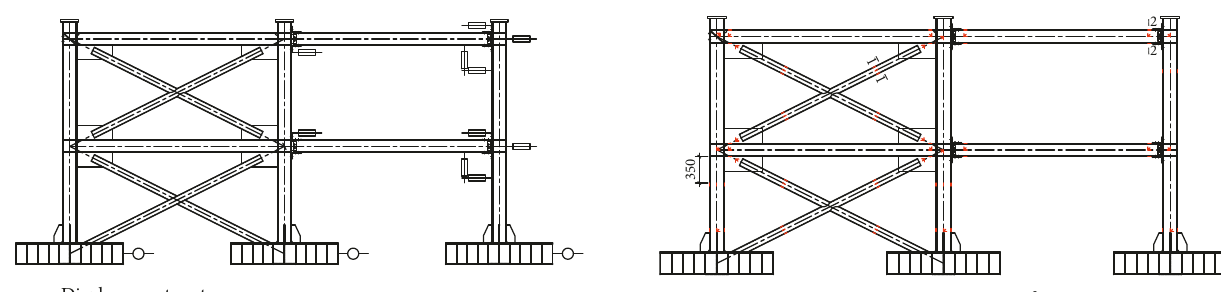
Figure 5: Measurement of